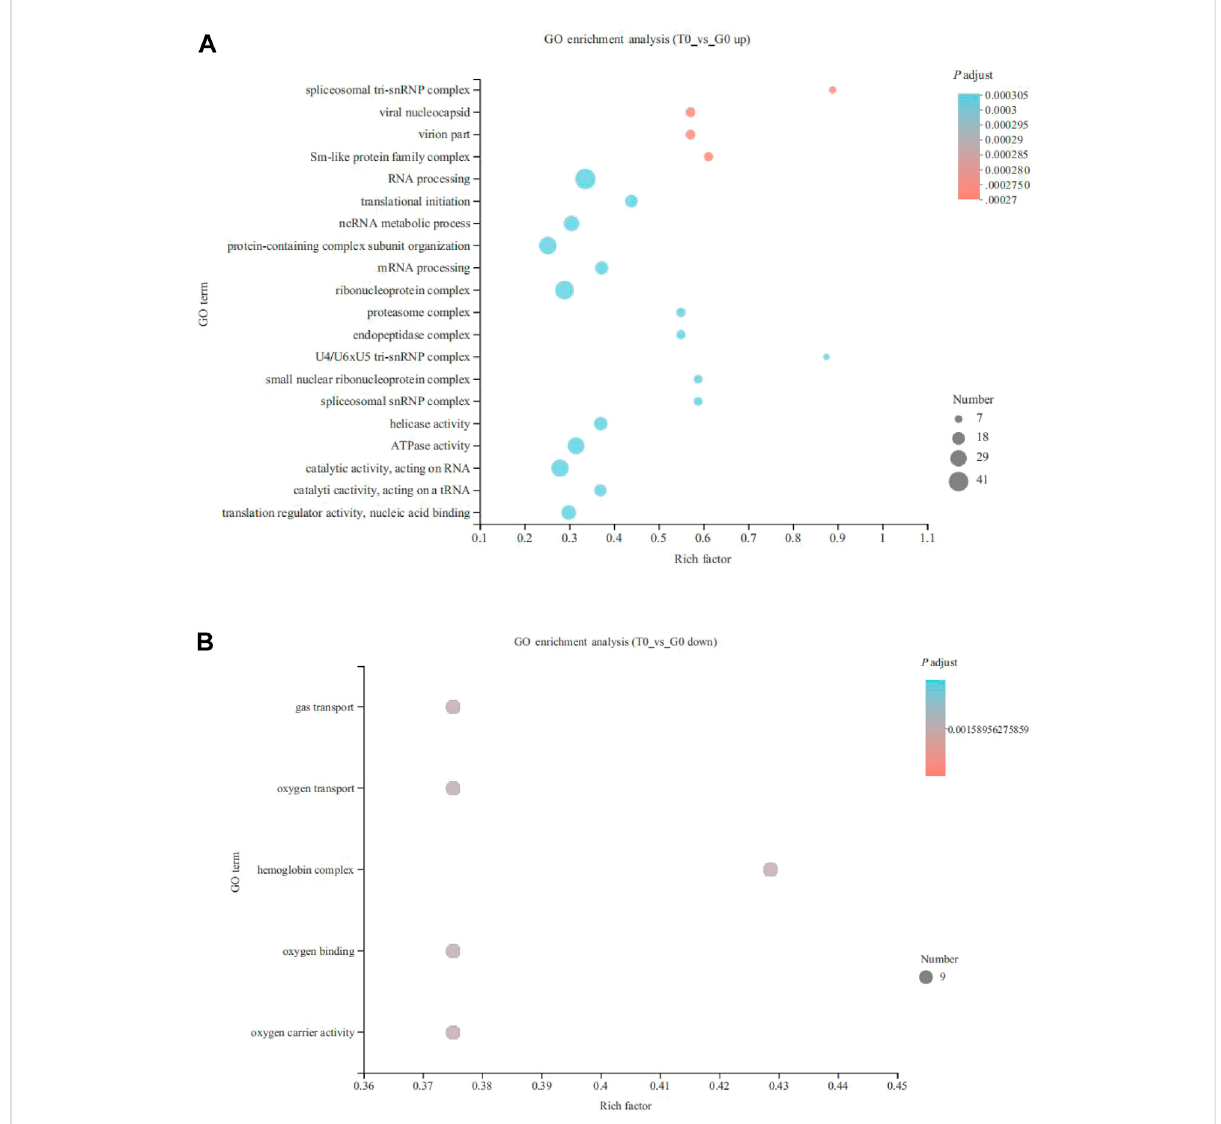
FIGURE 2 Gene Ontology (GO) enrichment analysis of the DEGs derived from the fi sh subjected to cold stress. (A) upregulated genes. (B) downregulated